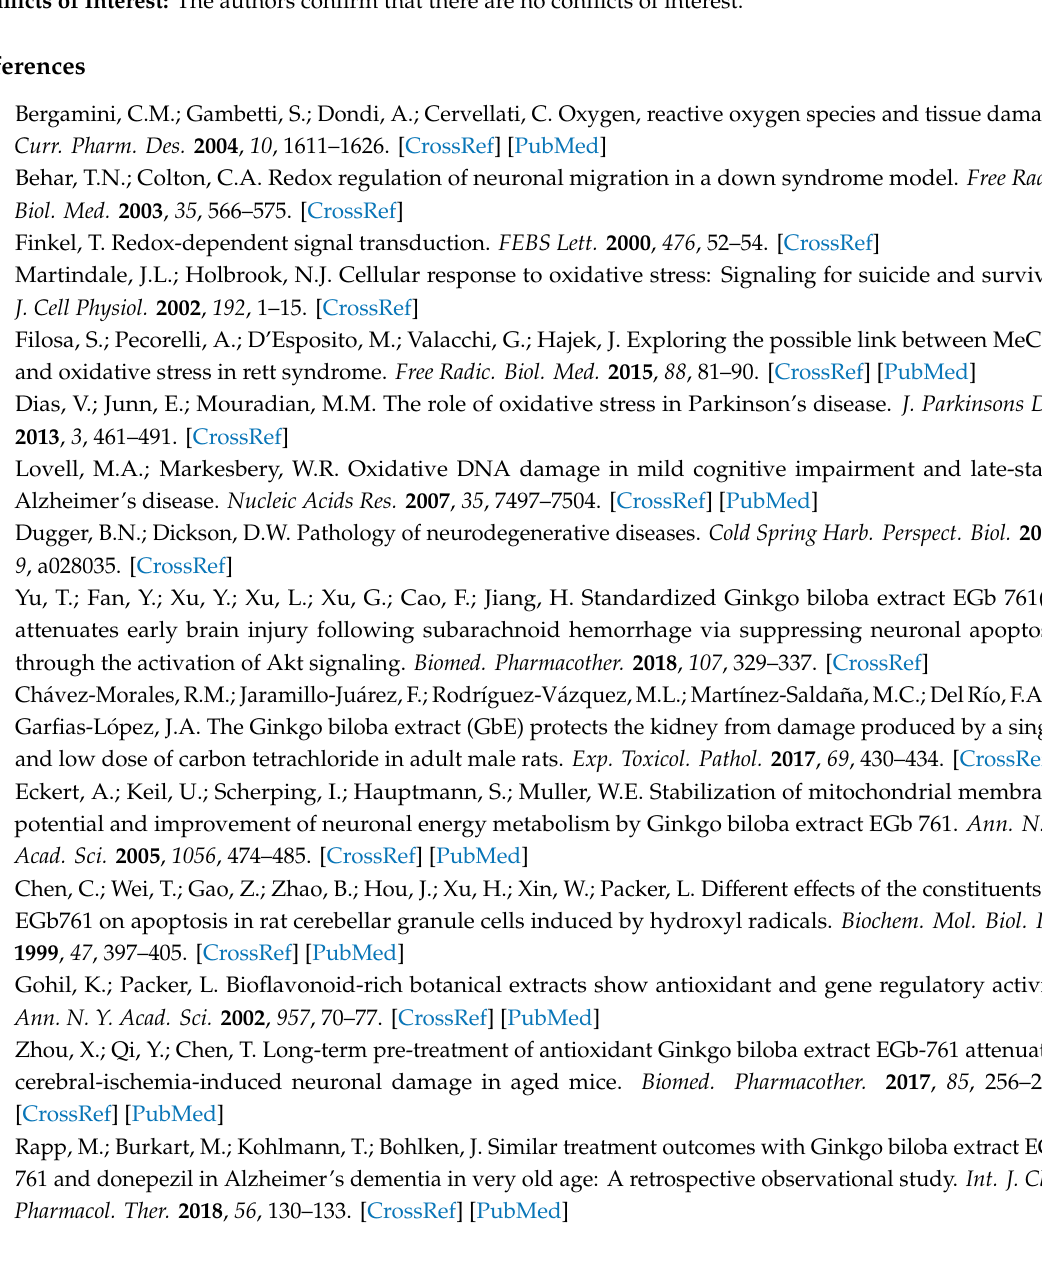
were used as control. Figure S2 : q-PCR analysis. Quantitative analysis of mRNA expression levels of p53, BAX and Bcl-2 in SK-N-BE cells after treatments. Histograms report the expression of p53 ( A ) and BAX / Bcl2 ratio ( B ). The bars represent ± the average ± SD of independent experiments ( n = 3). Statistically significant di ff erence compared to untreated cells: ** p ≤